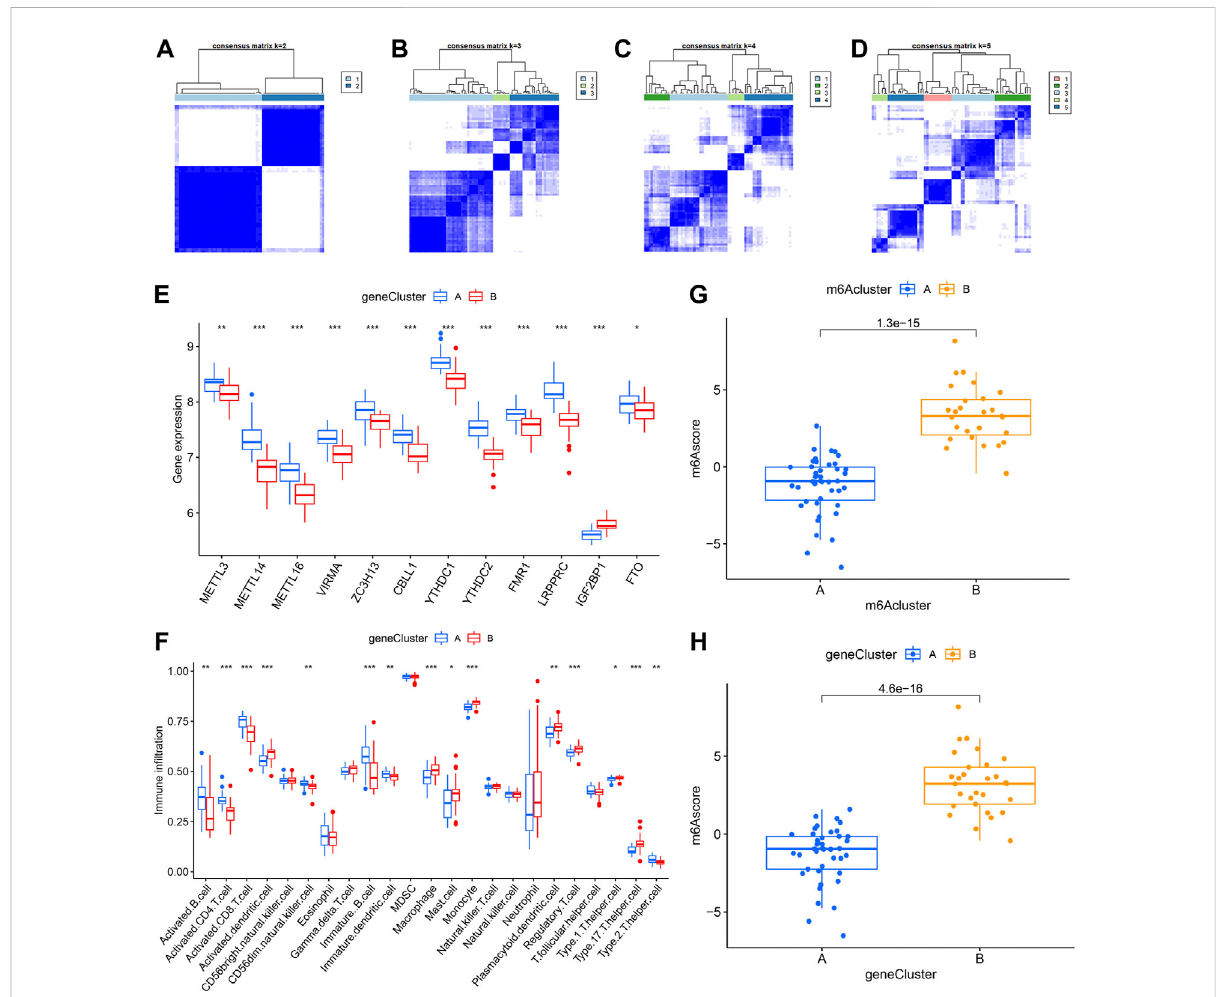
FIGURE 8 Consensusclusteringofthe402m6A-relatedDEGsinIPF. (A – D) Consensusmatriceswithclustercountfrom2to5showinganoptimalcluster (geneclusterAandgeneclusterB)withk=2. (E) DifferentialexpressionhistogramingeneclusterAandgeneclusterB. (F) Distinctionofimmunecells in fi ltration between gene clusterA and gene clusterB. (G) Distinction of m6A score between clusterA and clusterB. (H) Distinction of m6A score between gene clusterA and gene clusterB. * p < 0.05, ** p < 0.01, and *** p <